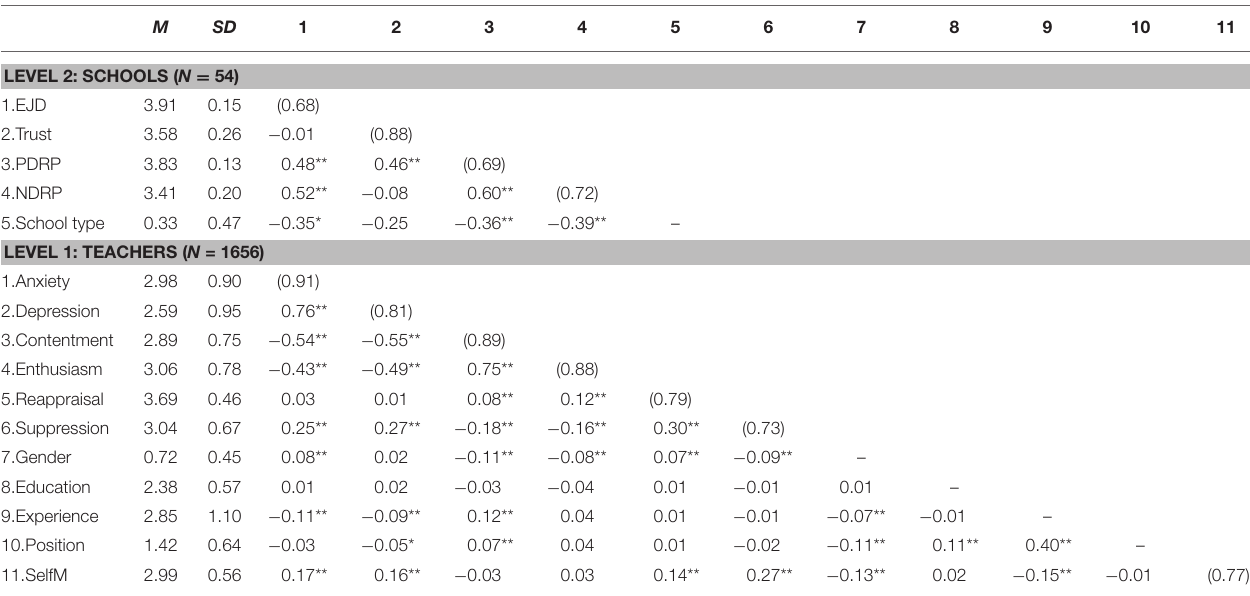
TABLE 1 | Mean, standard deviation, and correlations for all variables in two-level